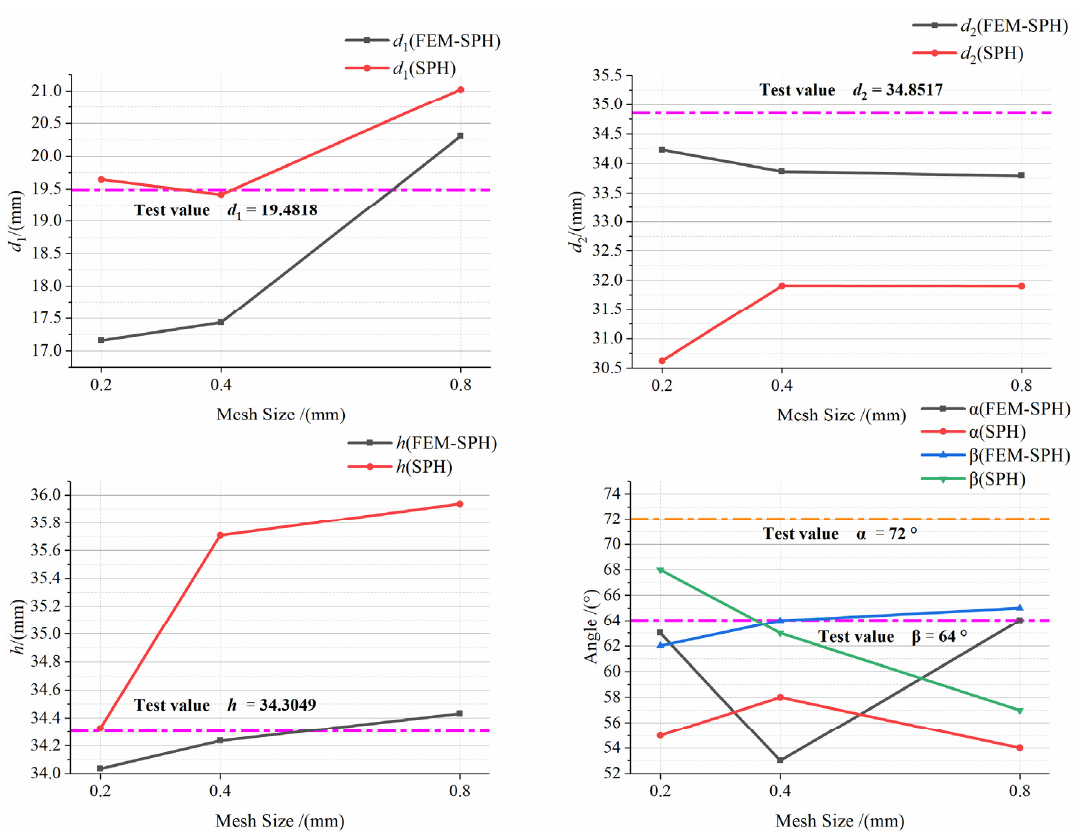
Figure 22. Comparison of simulation data and test data of debris cloud characteristic parameters.